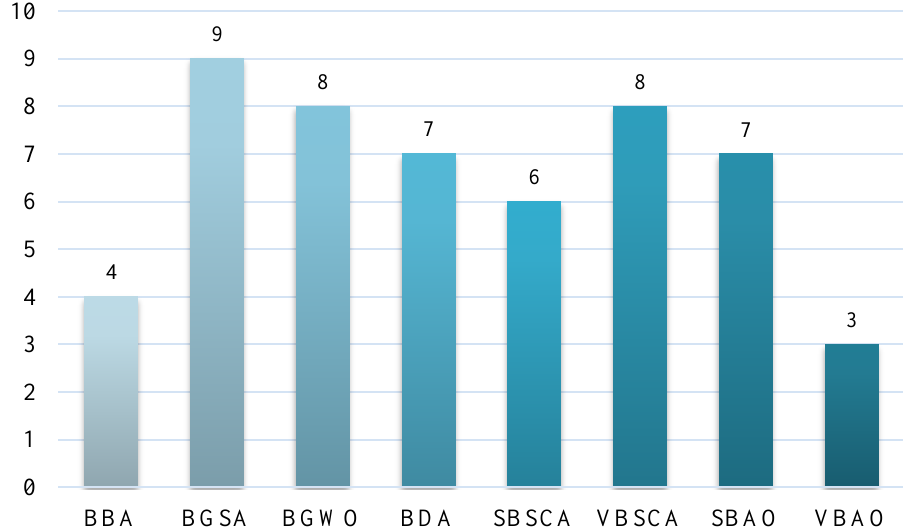
Figure 7. The number of selected features gained by BAO and comparative algorithms.